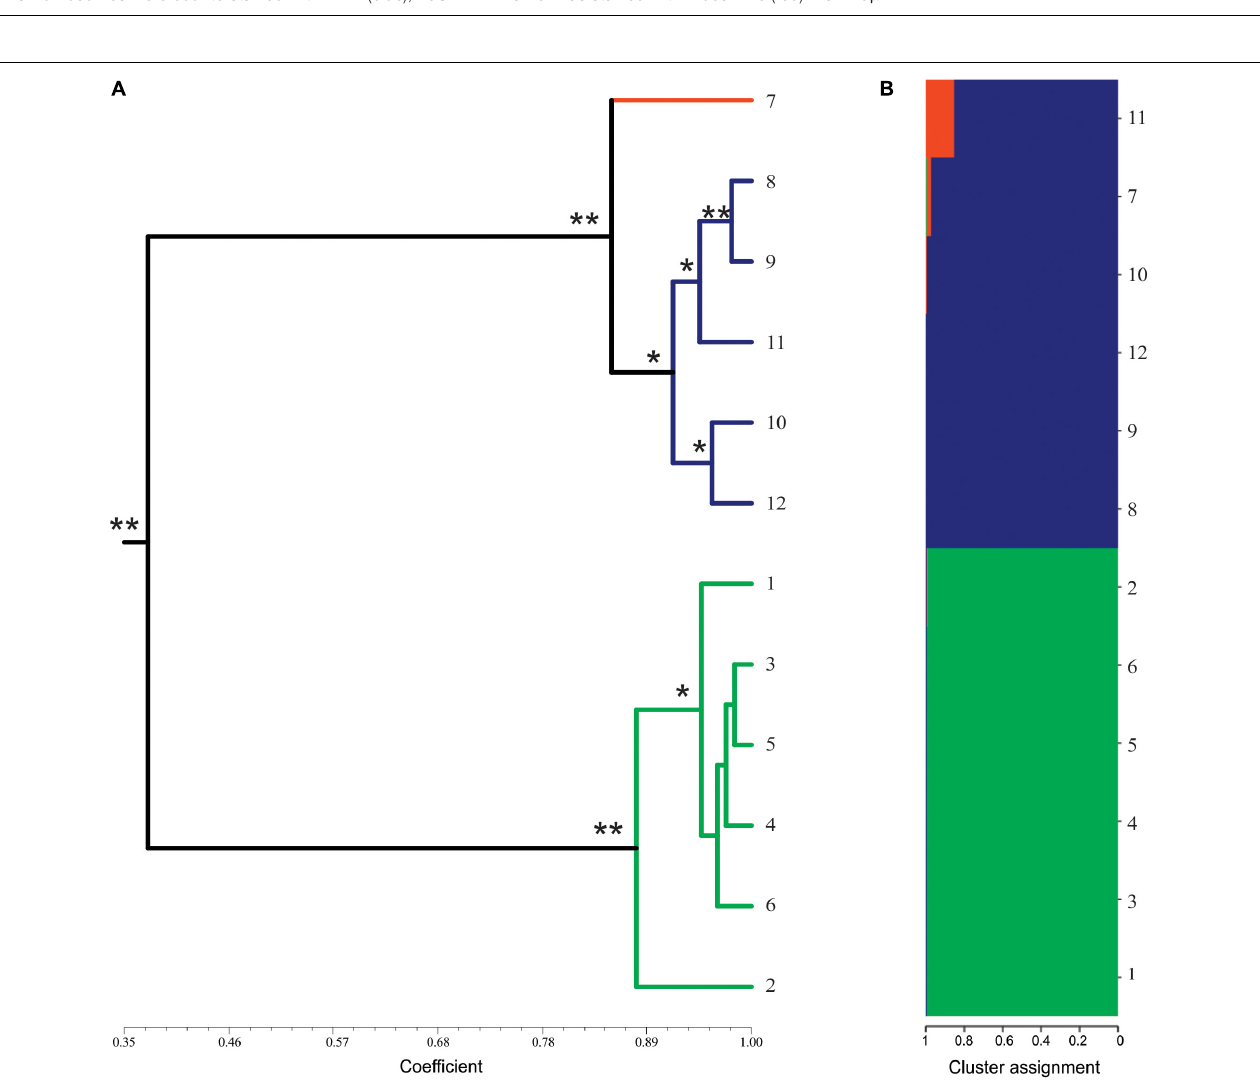
FIGURE 2 | Representative metaphases of three Lippia alba cytptypes: (A) diploid (2 n = 30), (B) triploid (2 n = 45), and (C) tetraploid (2 n = 60) individuals. Chromosomes were counterstained with DAPI (blue), 45S rDNA marker was stained with rhodamine (red). Bar = 5 µ m.